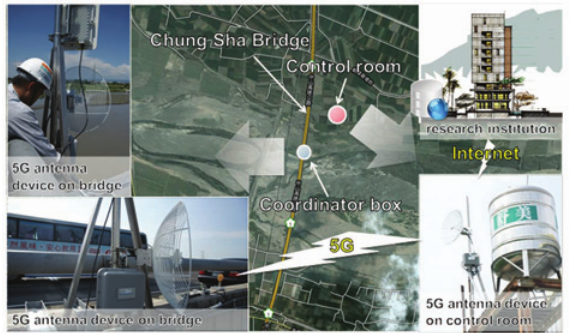
Fig. 7. Data transmit